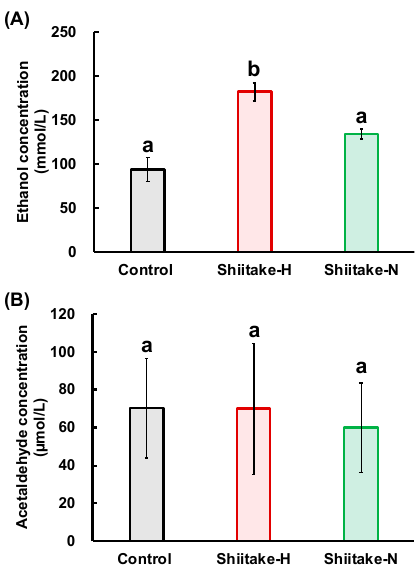
Figure 8. Effect of shiitake extract on residual ethanol and acetaldehyde concentrations in the stomach. ( A ) Ethanol concentration; ( B ) acetaldehyde concentration. Results with different letters are significantly different at p < 0.05. Data are the means ± S.D. n = 6.